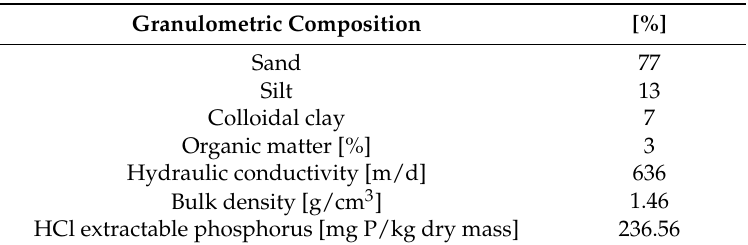
Table 1. Characteristic of soil used in the experiment.